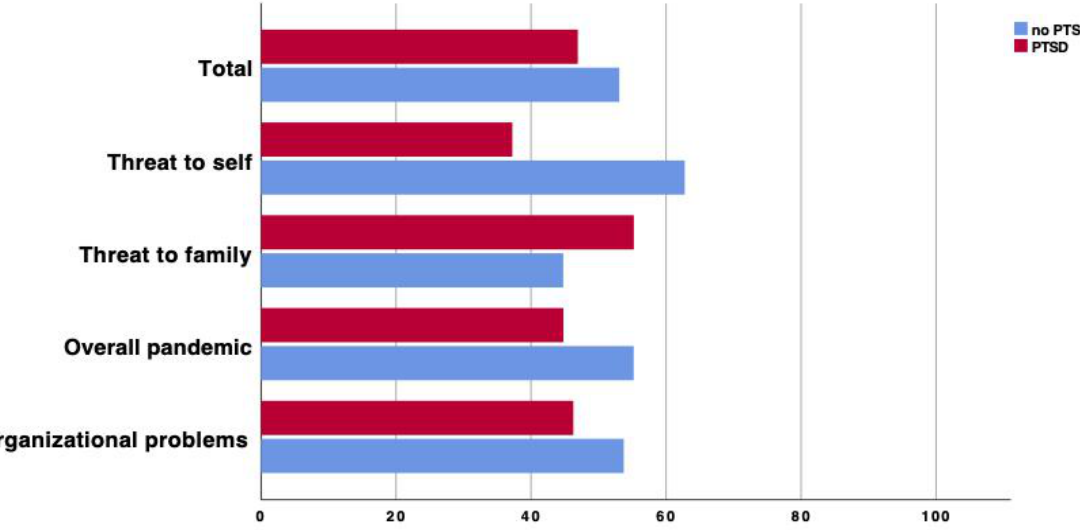
Figure 1. Prevalence of putative PTSD among 554 IES-R respondents by type of traumatic event.